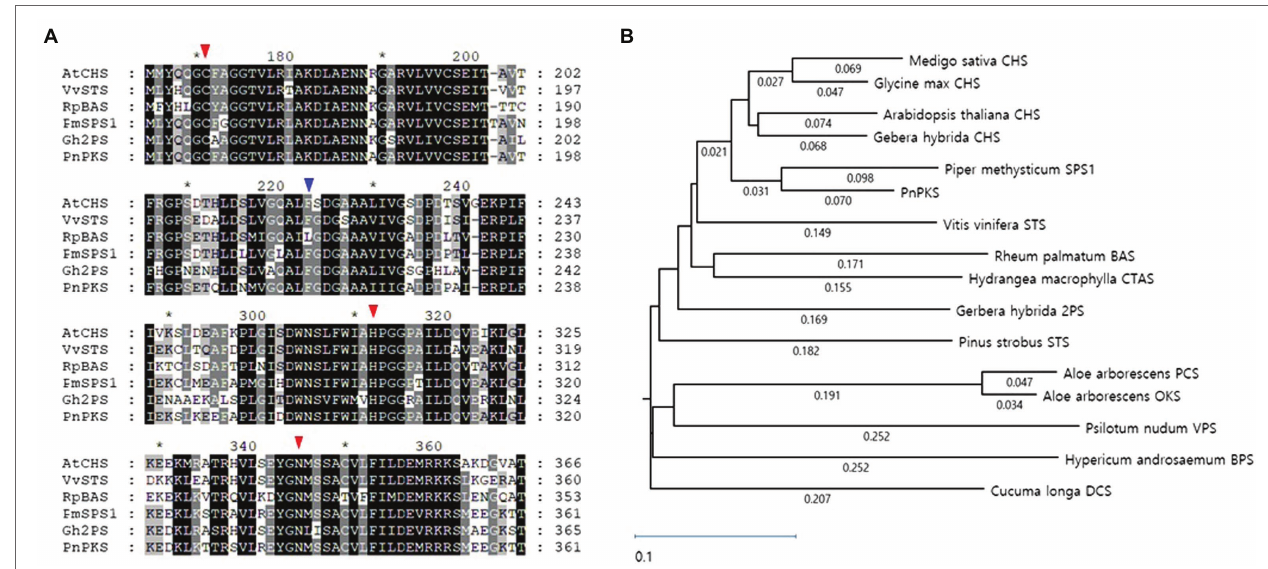
FIGURE 3 | Alignment (A) and phylogenetic analysis (B) of PnPKS against known CHS-superfamily type III PKS. (A) The red triangle indicates the three amino acids forming a Cys-His-Asn catalytic triad that is essential for starter substrate loading and malonyl-CoA condensation. The blue triangle indicates a “gate-keeper” that is known to adjust the chain elongation. (B) Arrow indicates PnPKS in this study. The sources and GenBank accession numbers are AtCHS from Arabidopsis thaliana (P13114), VvSTS from Vitis vinifera (ABE68894), RpBAS from Rheum palmatum (AAK82824), PmSPS1 from Piper methysticum (QCX36371), Gh2PS from Gerbera hybrida (P48391), CHS from Medigo sativa (AAB41559), Glycine max (P19168.1), and Gerbera hybrid (P48390.1), CTAS from Hydrangea macrophylla (BAA32733.1), OKS from Aloe arborescens (Q3L7F5.1), PCS from Aloe araborescens (Q58V97.1), VPS from Psilotum nudum (Q9SLX9.1), STS from Pinus strobus (P480407.1), BPS from Hypericum androsaemum (Q8SAS8.1), and DCS from Curcuma longa (C0SVZ5.1). The nucleotide sequence of the pnpks gene from Piper nigrum is provided in the Supplementary data section. Amino acid sequences were aligned using the ClustalW method and the phylogenetic tree constructed by using the MegAlign program of the DNASTAR Lasergene software (DNASTAR Inc.).